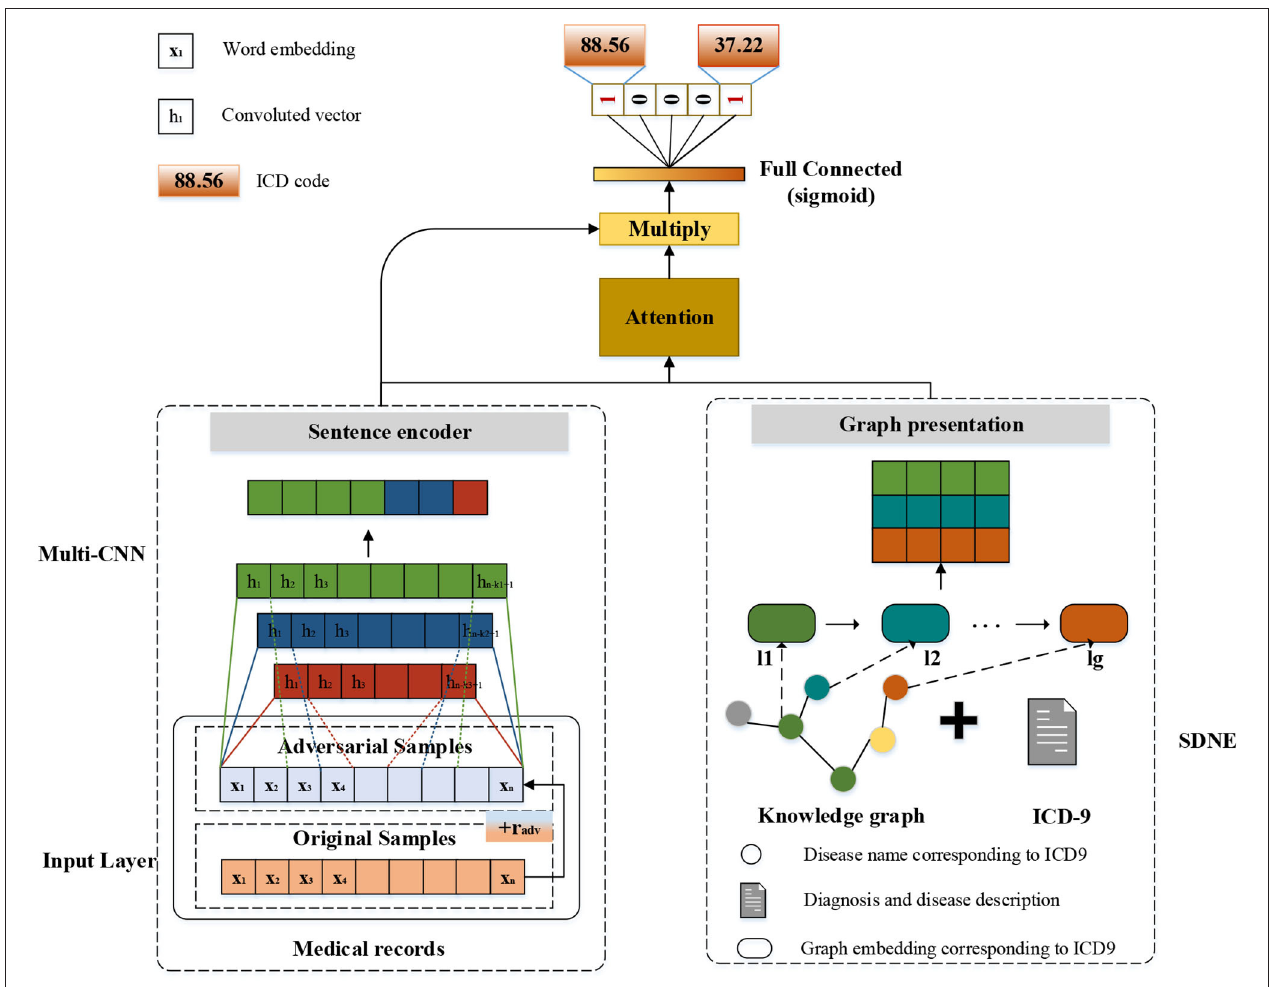
FIGURE 3 | The overview of G_Coder.